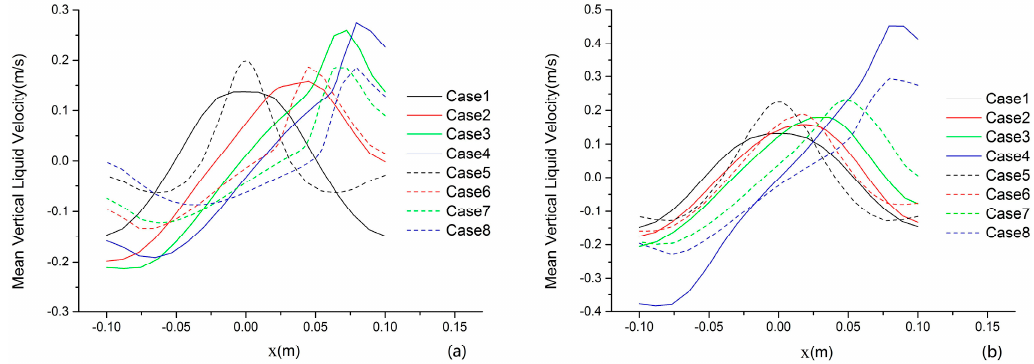
Figure 7. Liquid velocity in the y-direction at z = 0 m at different heights in the bubble column: ( a ) 0.09 m and ( b ) 0.22 m.